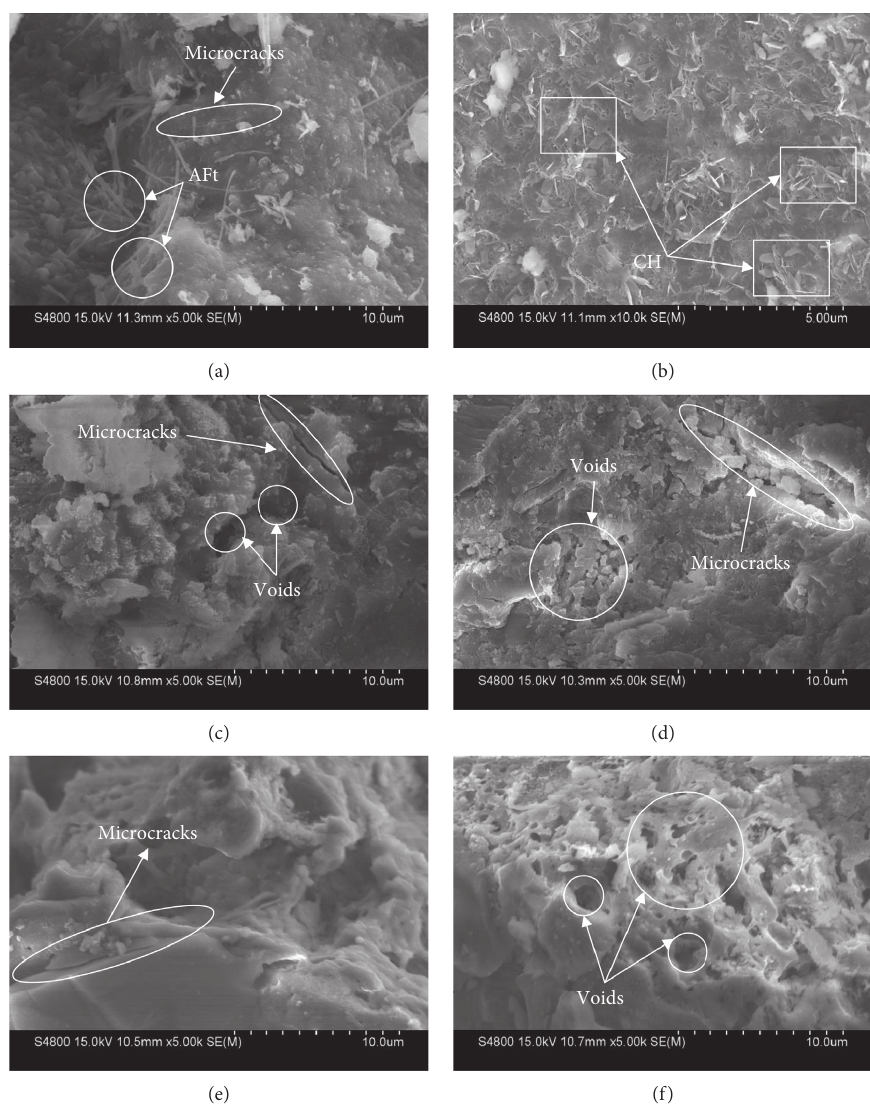
Figure 9: Microstructure of CITP15 (a) at room temperature; (b) at 200 ° C; (c) at 400 ° C; (d) at 600 ° C; (e) at 800 ° C; and (f) the sample CITP30 at 800 °